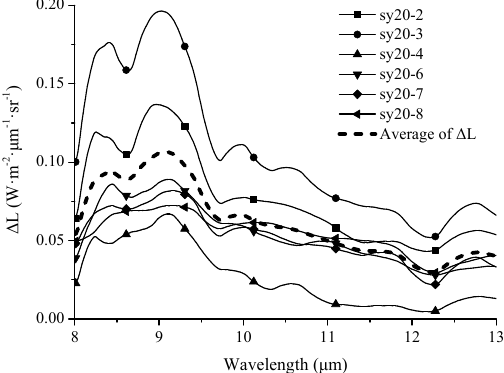
Figure 4. Six radiance increment spectra of sandstone samples and the average spectrum with the extensional fissure mode.